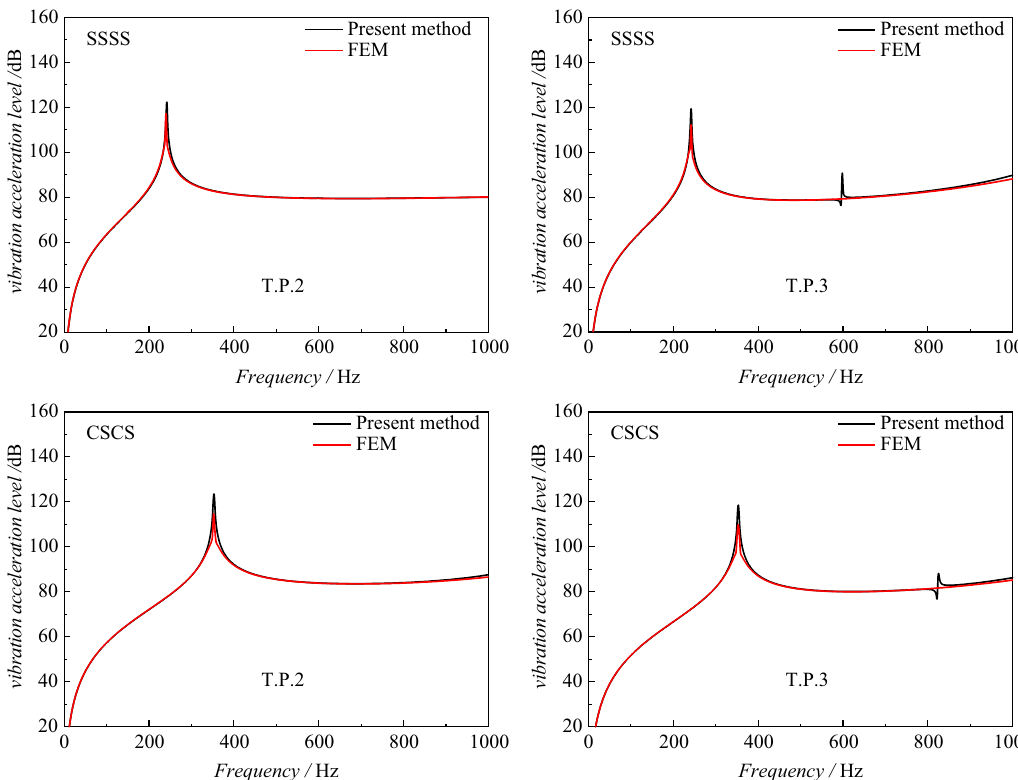
Figure 9: Comparison of the steady vibration response of the present method and FEM